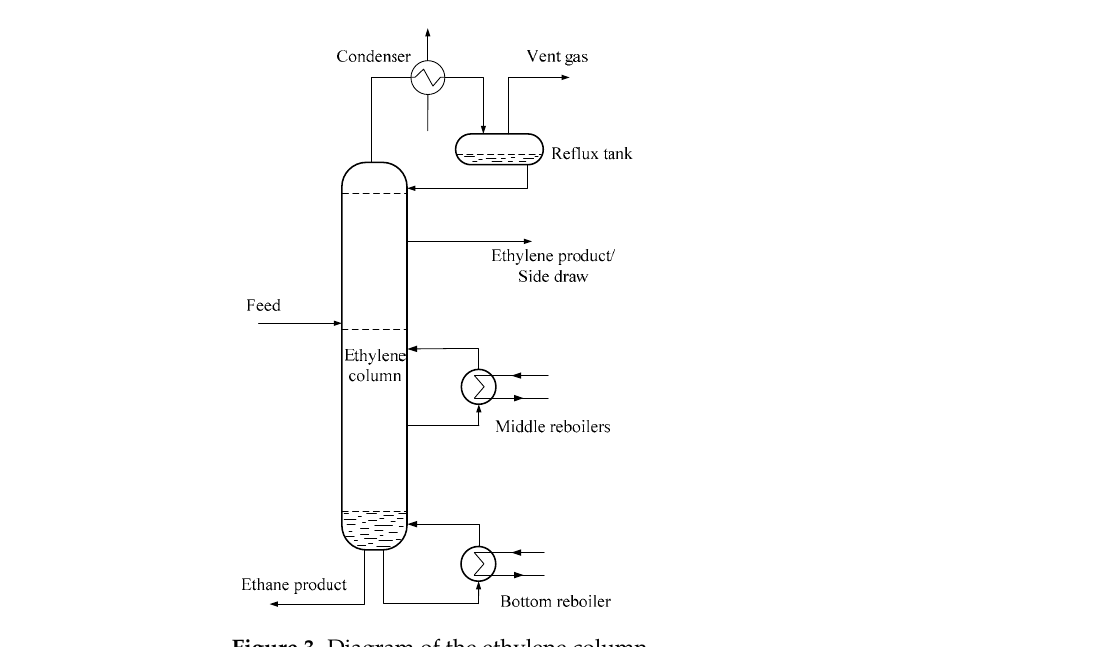
Figure 3. Diagram of the ethylene column. Table 2. Data in diverse working